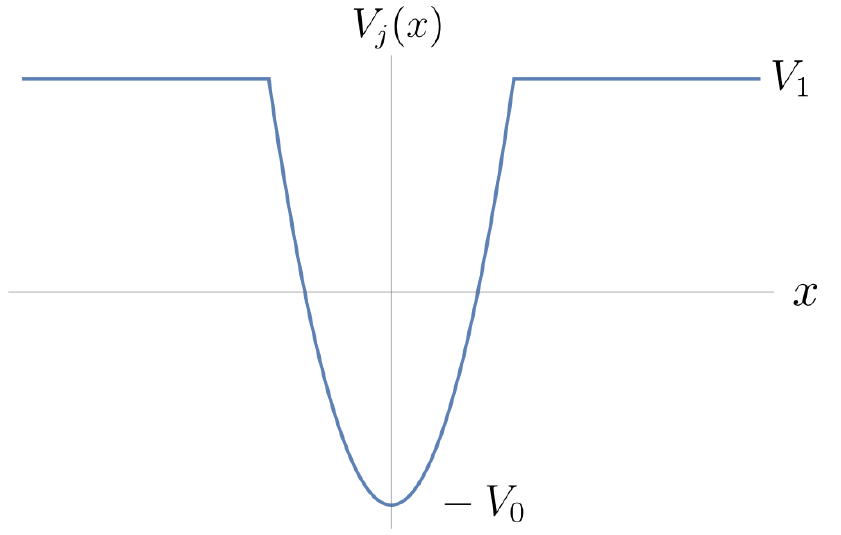
Figure 1 . The potential in our toy model. The real shape of the e(cid:11)ective potential for timelike particles in a microstate geometry is a smoothed